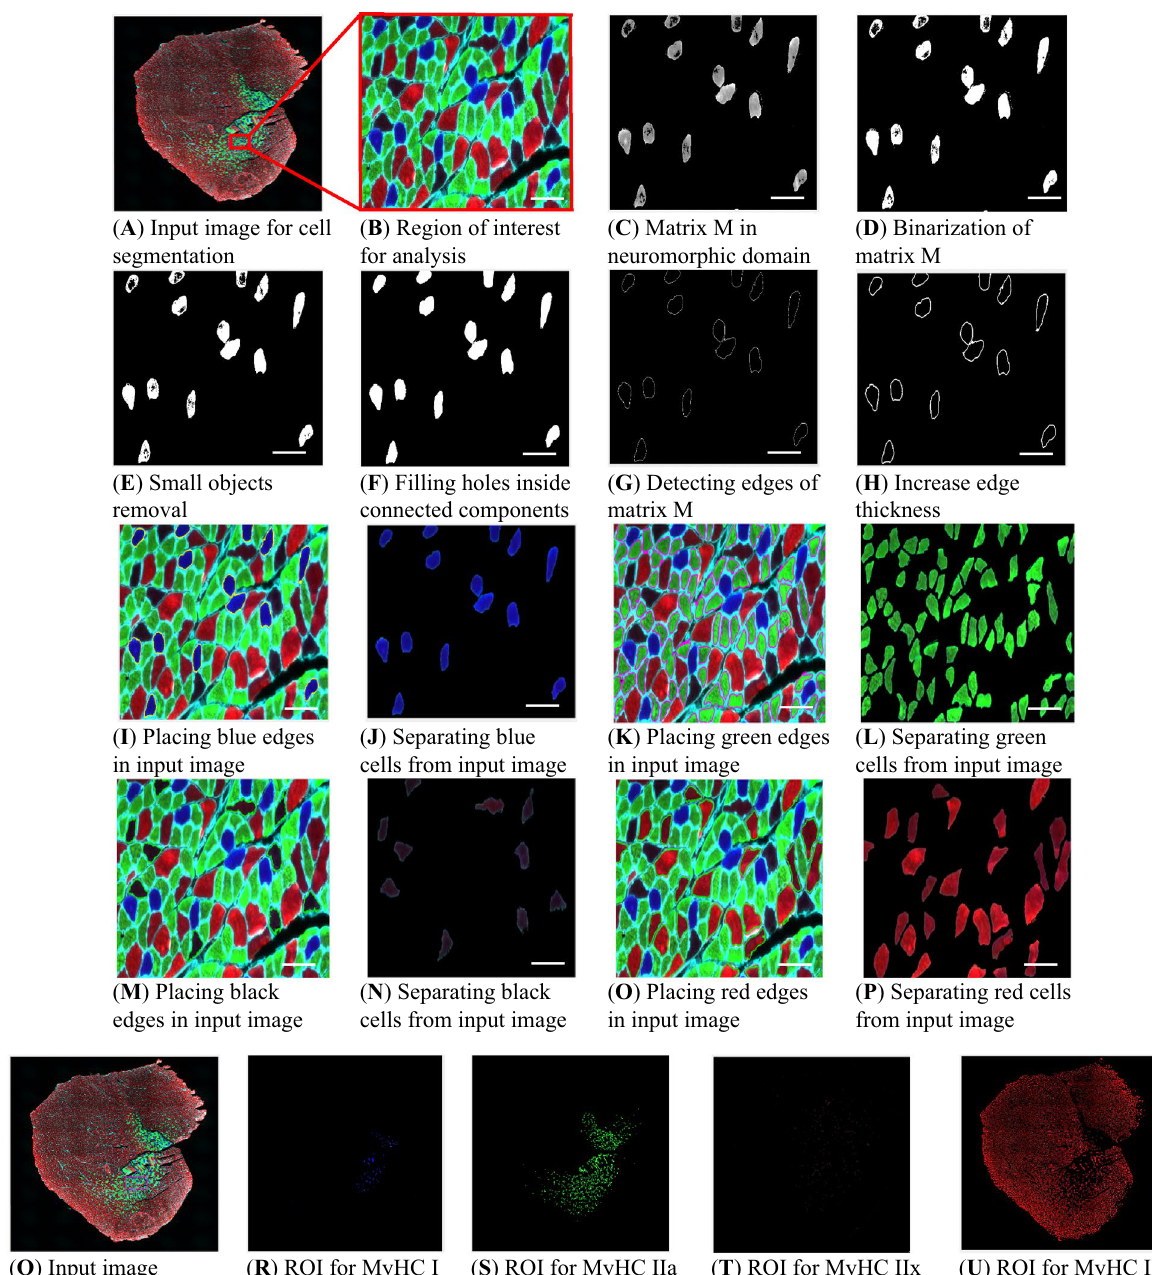
Figure 2. MyoView workflow for different cell types. ( A ) When the MyoView software starts, a window automatically opens to select the image to be analyzed (here muscle cryosections immunostained for laminin (white), MyHC I (blue), MyHC IIa (green), and MyHC IIb (red)). ( B ) Represents zoom-in example of a specific area. ( C ) MyoView computes matrix M in neuromorphic domain from input image. ( D-H ) After binarization of matrix M, removing small objects, and filling holes inside the connected components, then the software detects edges of matrix M and for better visualization increases edge thickness. ( I ) To dabble-check the detecting process, the software places edges in input image. ( J ) Finally, the software separate edges from input image and finalize the analyzing process (here for MyHC I myofibers in blue color). ( K-l ) Represent the same process for MyHC IIa myofibers in green color. ( M–N ) Represent the same process for MyHC IIx myofibers in black color. ( O-P ) Represent the same process for MyHC IIb myofibers in red color. ( Q-U ) Represent the segmentation process of different myofibers in the whole image. Bars = 25